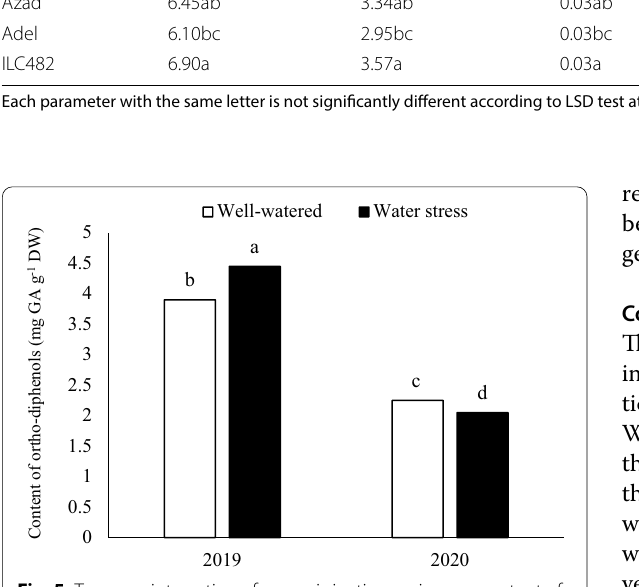
irrigation regime on content of ×